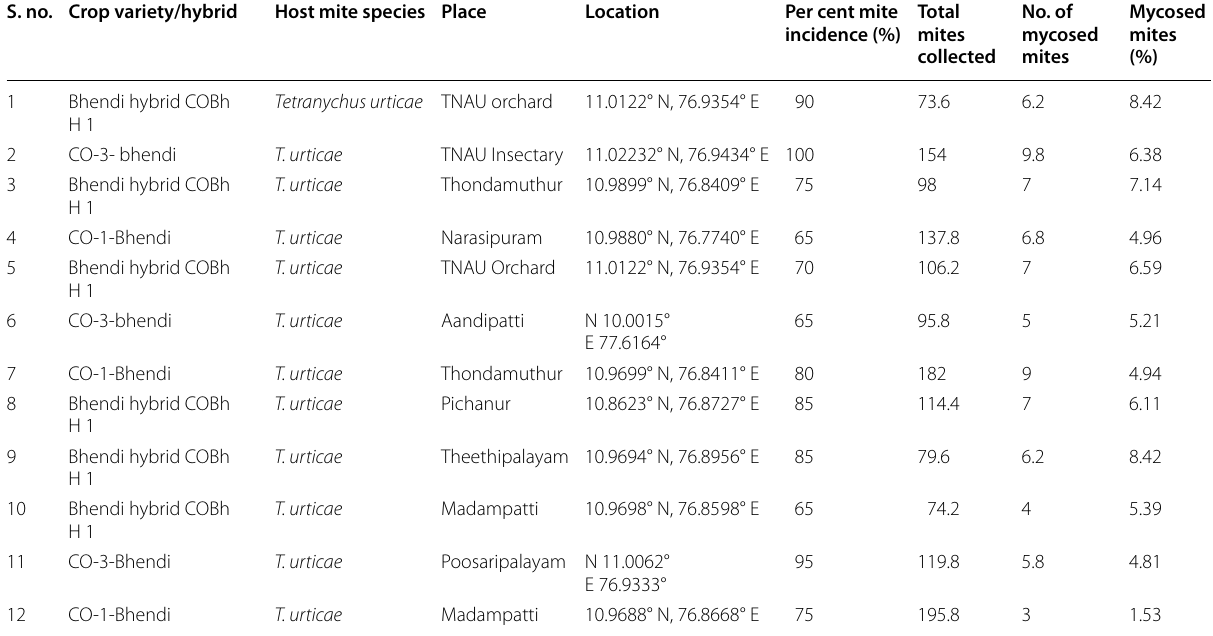
Table 1 Survey and incidence of entomopathogenic fungi infestation on two-spotted spider mite, Tetranychus urticae in Bhendi S. no. Crop